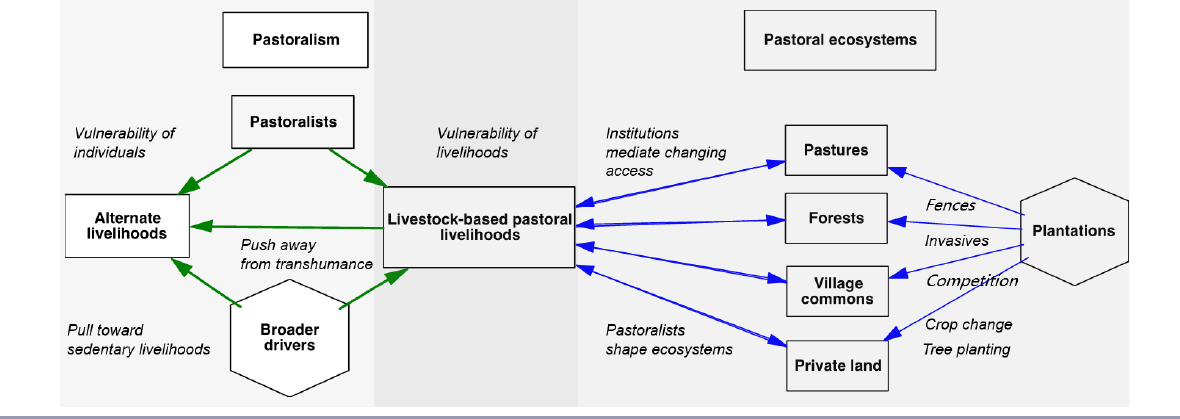
Fig. 1 . An integrated framework of pastoral